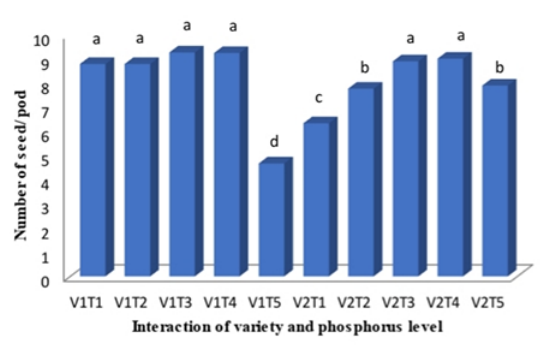
Figure 4 Interactive effect of varieties and different levels of phosphorus on the number of seeds per pod in mungbean.